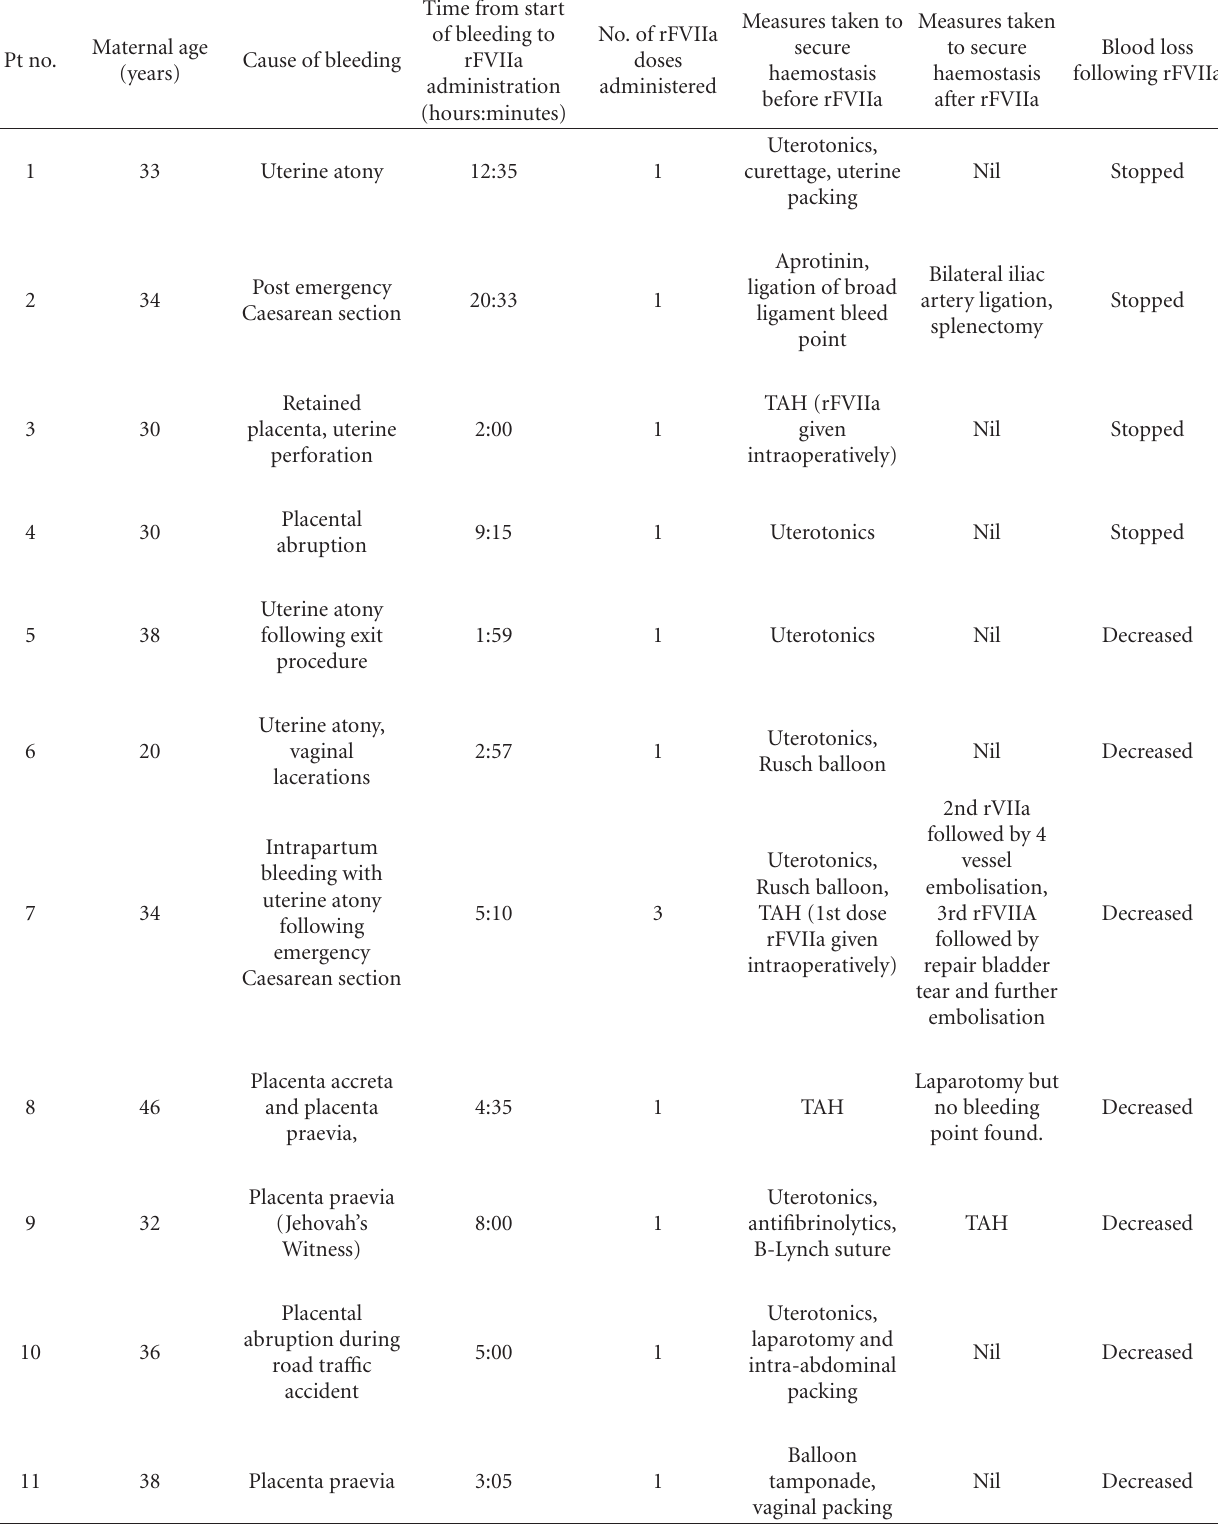
Table 1: Clinical indication and response to rFVIIa following major obstetric haemorrhage. rFVIIa—recombinant activated factor VII, TAH—total abdominal hysterectomy.